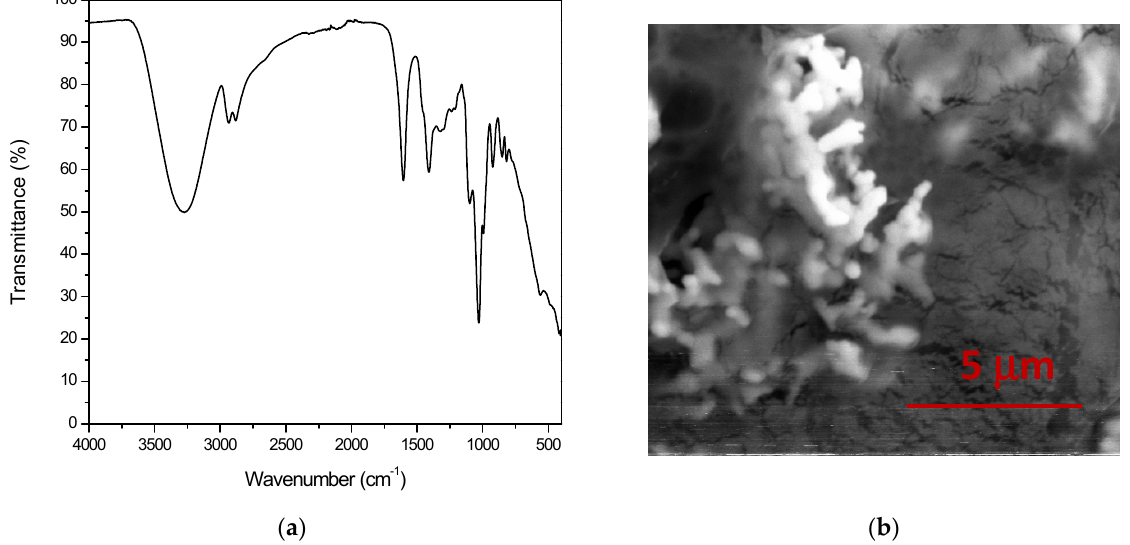
Figure 6. FT-IR spectrum ( a ) and SEM image ( b ) of NiMn 2 O 4 -alginate film.